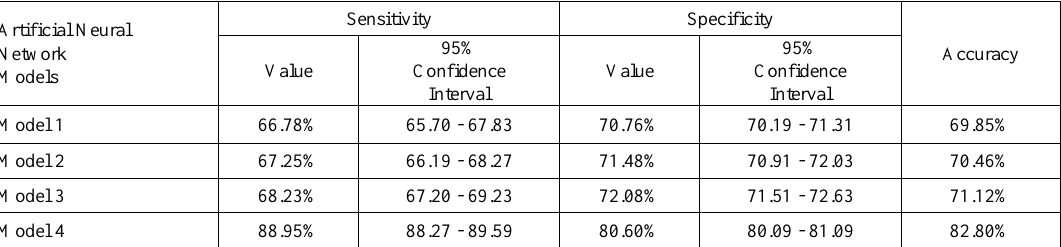
Table 3. ANN training results: sensitivity, specificity and